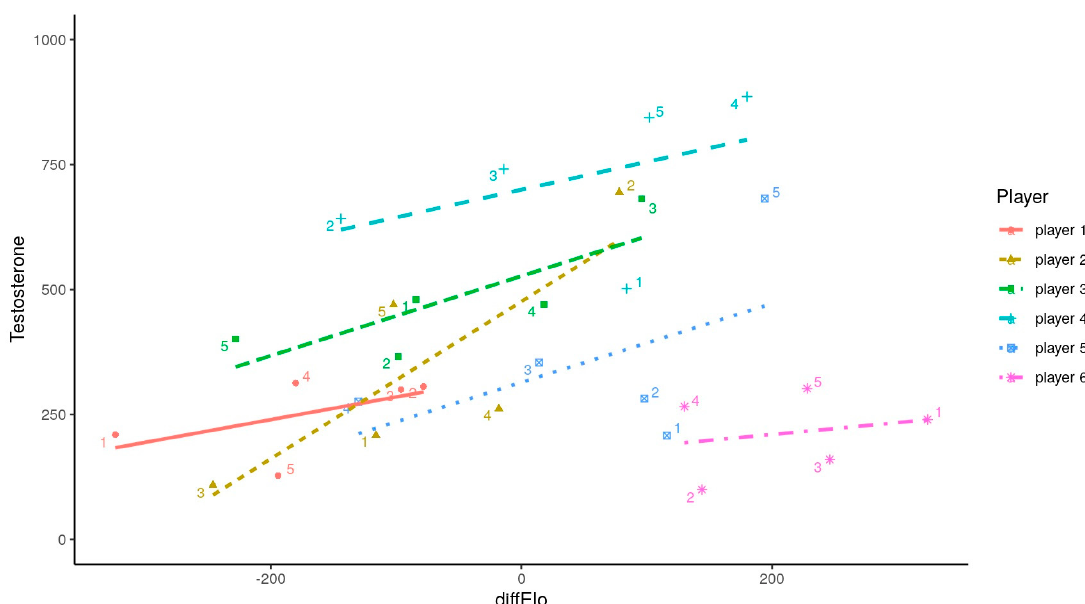
Figure 1. Individual salivary testosterone (pg/mL) production related to opponent´s ELO difference and number for each round. difELO = ELO difference between opponents; J1 = player 1; J2 = player 2; J3 = player 3; J4 = player 4; J5 = player 5; J6 = player 6.